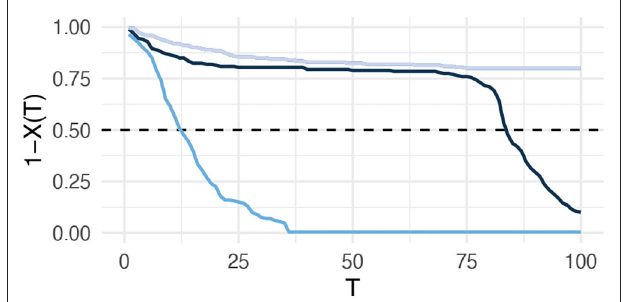
X ( T ) over time T for − 0.5, b = =